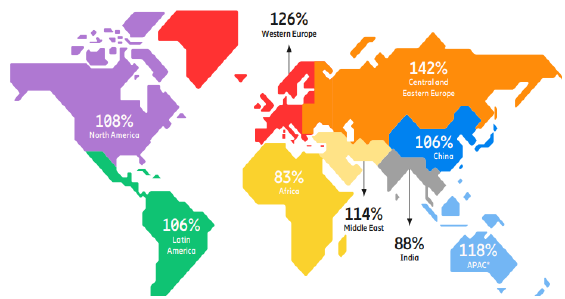
Figure 3: No of subscribers Vs. No of subscriptions